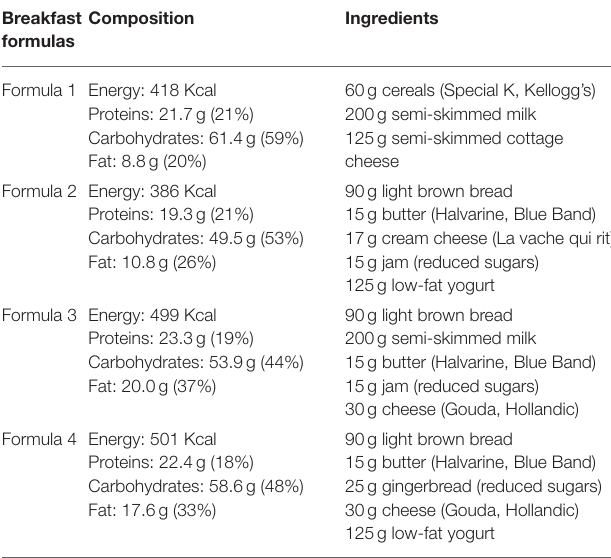
TABLE 3 | Standardized breakfast formulas. Breakfast Composition Ingredients formulas